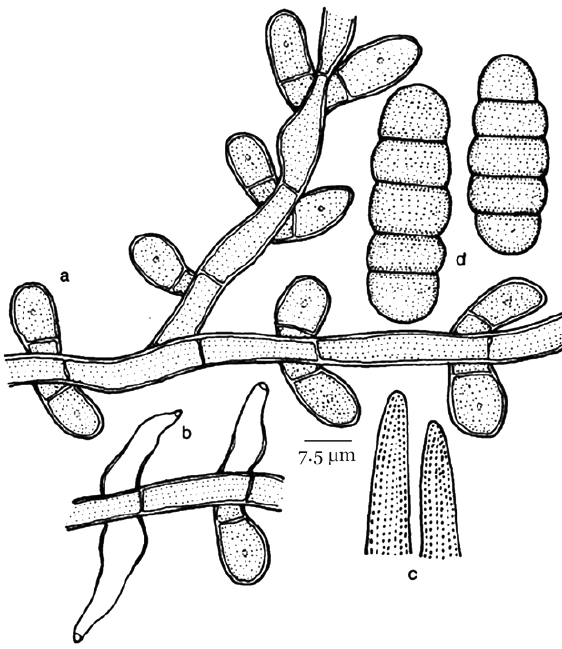
Figure 60. Meliola capensis var. schleicherae a - Appressorium; b - Phialide; c - Apical portion of mycelial setae; d - Ascospores